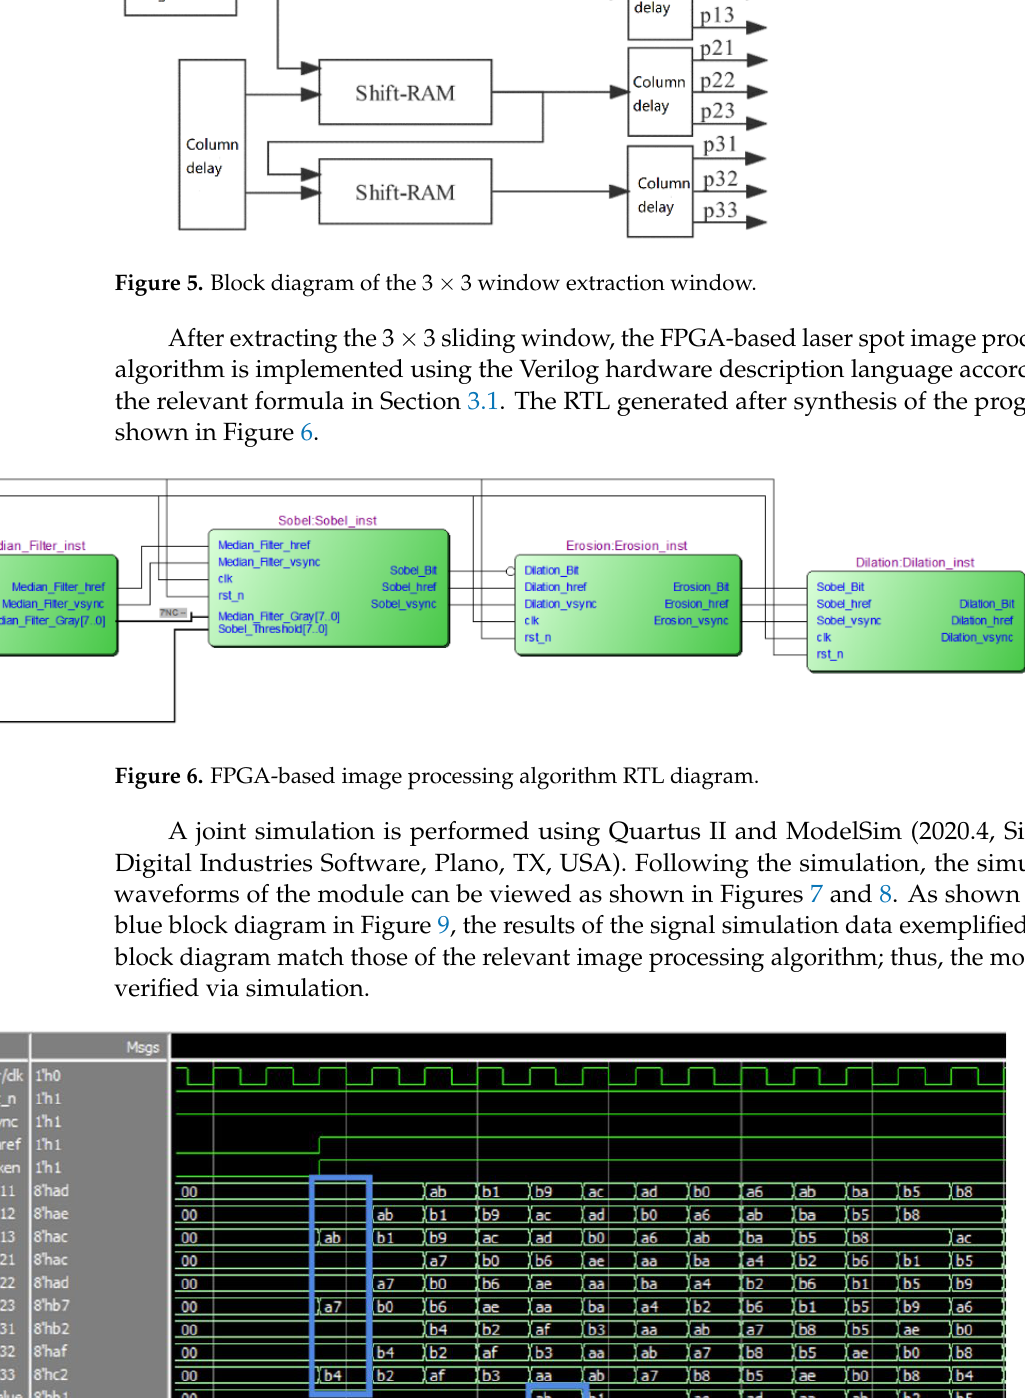
Figure 7. Median filtering algorithm simulation module.